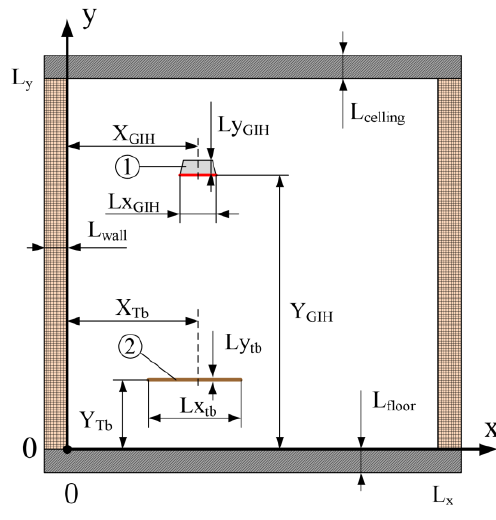
Figure 6. Problem solution area: 1—GIH; 2—Panel. The location coordinates of the radiant energy source and the horizontal panel corresponded to the most typical variation in their placement in a real premises (Figure 1). Coordinates ( X Tb , Y Tb ) of the upper boundary center of the horizontal remote panel surface varied in the x and y directions. The value of air pressure was taken as p air = 0.1 MPa and did not change with time in the entire problem solution area. When modeling radiative heat transfer, air was considered a diathermic medium, and all surfaces (enclosing structures, GIH and equipment) were opaque gray.